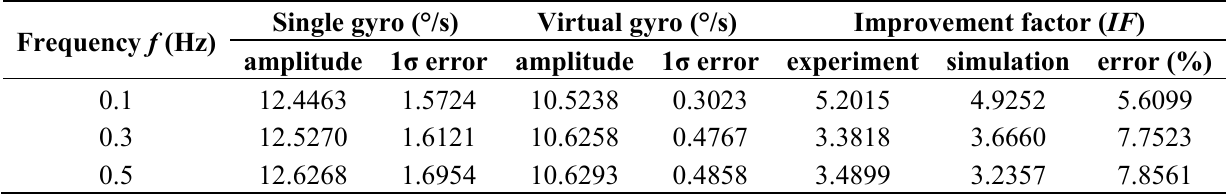
Table 5. Swing rate test results of the virtual